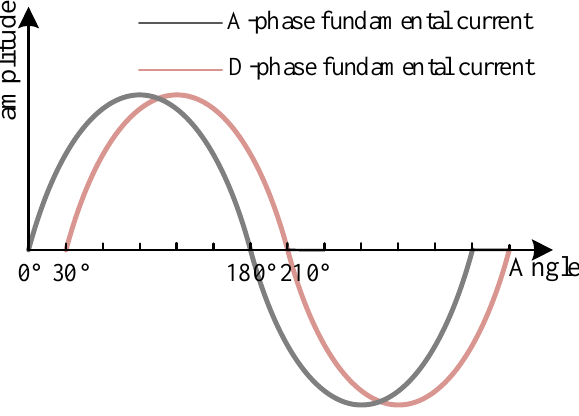
Figure 6. Current phase difference between two sets of windings.